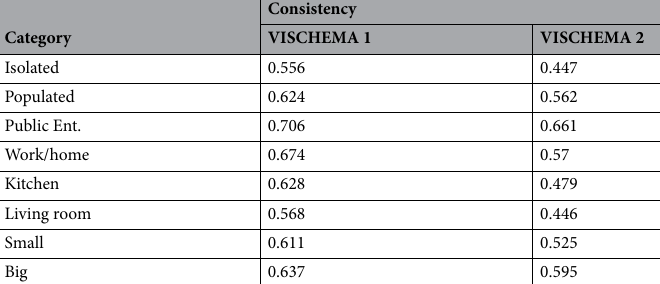
Table 1. Vischema 1 and Vischema 2 consistency, per category. Certain categories of images, such as kitchens or scenes involving public entertainment (playgrounds, theme parks) are more consistent than others, such as the isolated category. Higher consistency implies participants agreed on specific features that made the image